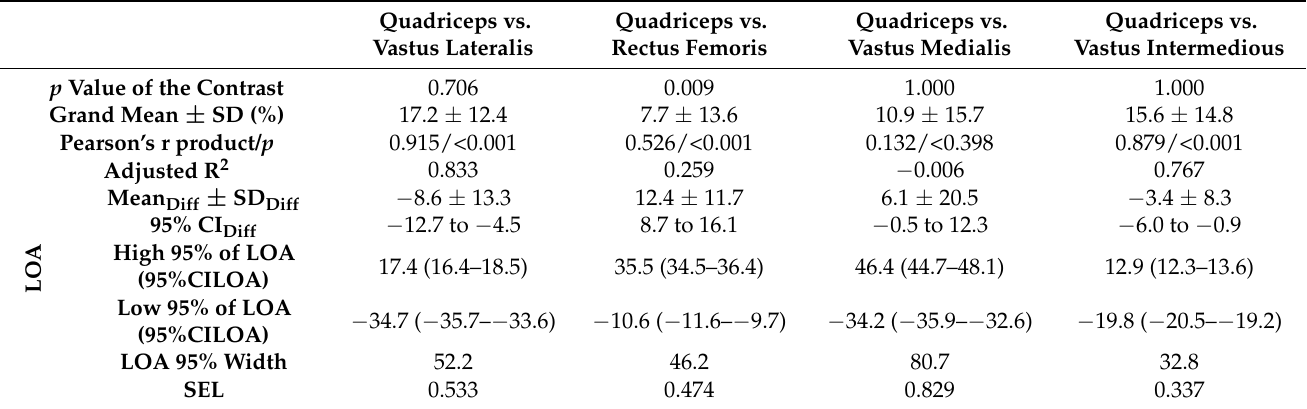
Table 1 present the results of the absolute agreement analyses between the training- induced changes (%) of CSA of T versus those of VL, RF, VM and VI. Representing graphs of Pearson correlations coefficients and Bland-Altman 95% limits of agreements plots for each comparison are presented in Figure 2. In short, only VL and VI CSAs percentage changes were highly related to those of T, predicting 0.83% and 0.76% the variations of quadriceps CSA training-induced changes. In addition, these correlations were accompanied by low values of means of the differences while small range of LOA and SEL values were observed, indicating a high agreement between these variables [36,37] (Table 1 and Figure 2). According to these results, the training-induced changes in VL and VI CSAs seem to be the best surrogates of T quadriceps CSA training-induced hypertrophy, at least when muscle hypertrophy is evaluated at the specific point used in the present study. Table 1. Results of absolute agreement analyses between the training-induced changes (%) of cross- sectional area (CSA) of Total Quadriceps versus those of vastus lateralis, rectus femoris, vastus medialis and vastus intermedious (N = 43). Quadriceps vs. Quadriceps vs. Quadriceps vs. Quadriceps vs. Vastus Lateralis Rectus Femoris Vastus Medialis Vastus